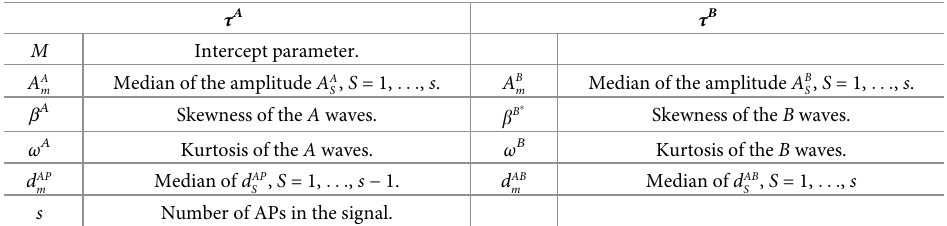
Table 3. Feature sets used in the prediction of the main HH